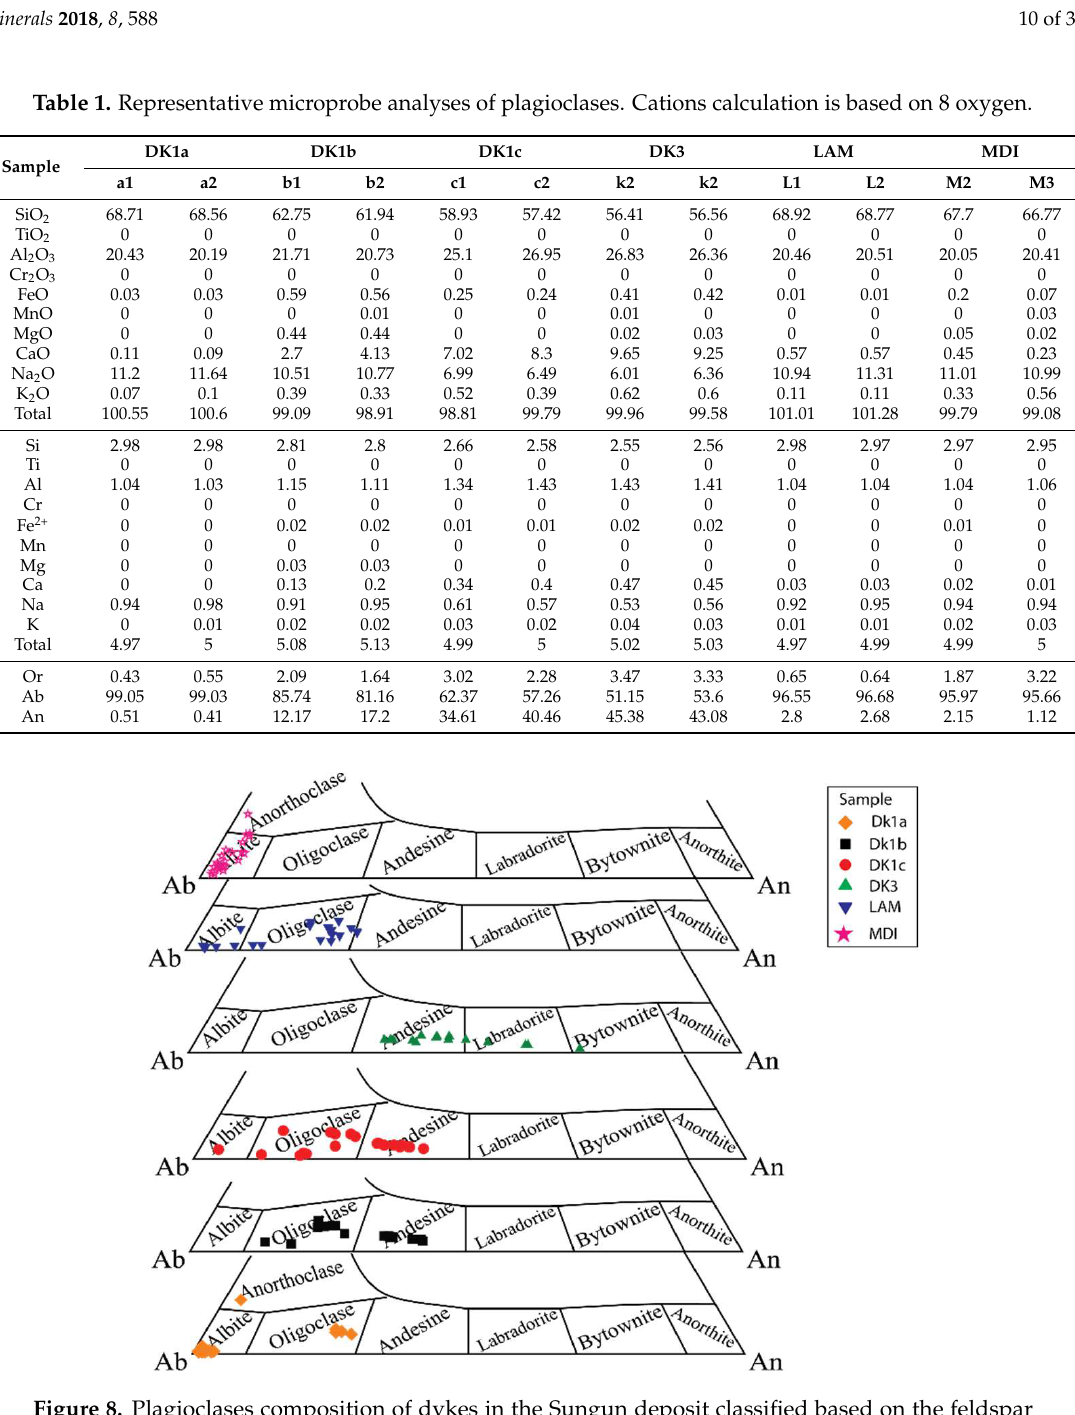
Figure 8. Plagioclases composition of dykes in the Sungun deposit classified based on the feldspar ternary diagram [31]. 252 Table 1. Representative microprobe analyses of plagioclases. Cations calculation is based on 253 8 oxygen. 254